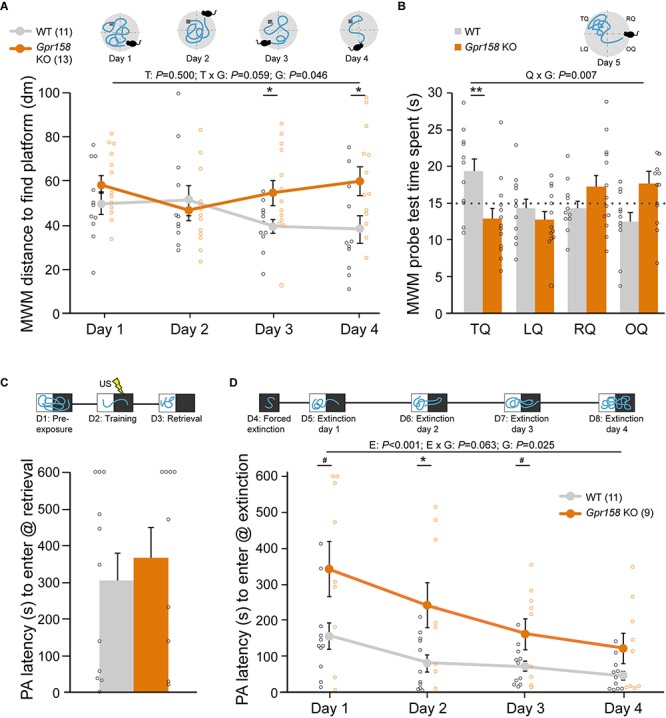
Gpr158 KO have a spatial memory deficit and show delayed safety learning. (A,B) Experimental set-up and data of training [see Online resource 3; (A) during four days of training, mice were placed in different locations in the circular pool and distance to reach the hidden platform (dark gray) was recorded], and probe test [B, time spent in each quadrant was recorded) in the Morris water maze (MWM]. (A) During MWM training, Gpr158 KO mice swam a longer distance to reach the platform and their performance did not reach WT levels [nWT = 11, nKO = 13; genotype (G) effect P < 0.046; training (T) effect P = 0.500, interaction P = 0.059]. (B)
Gpr158 KO mice showed a long-term memory deficit during the probe test [quadrant (Q) × genotype (G) P = 0.007], and spent less time in the target quadrant (TQ, RQ: right quadrant, LQ: left quadrant, OQ: opposite quadrant). (C,D) Experimental set-up and data of PA test and latency to enter the dark compartment after training (C) and during the four days after forced extinction (D). (C)
Gpr158 KO mice (n = 9) showed similar PA retention as WT mice (n = 11). (D) After forced extinction in the dark compartment, Gpr158 KO mice showed a delay in extinction learning [Extinction (E) P < 0.001, genotype (G) P = 0.025, interaction P = 0.063]. Data are presented as mean ± SEM with individual data points indicated. Asterisks and octothorpe indicate the level of significance between WT and KO assessed by Student’s t-test/MWU test (Supplementary Table 1), #P ≤ 0.100; ∗P ≤ 0.050; ∗∗P ≤ 0.010.